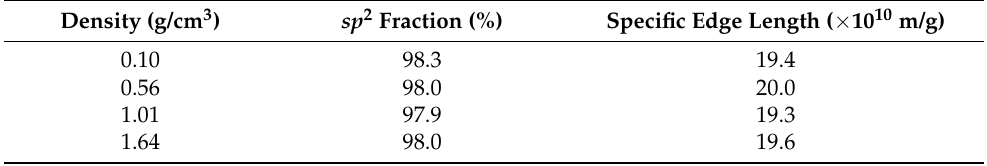
Table 1. Fraction of sp 2 atoms and specific edge length of several models with different densities.